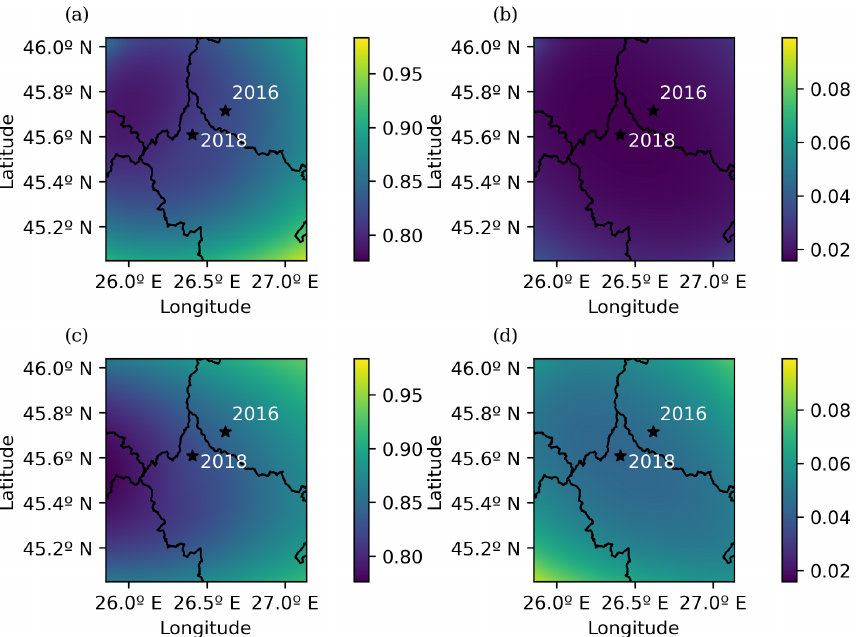
Figure 14. (a) The b -value spatial mapping for the Vrancea region from 2000 to 2016 using the parameters calculated in the previous Gaussian function fit, (b) b -value uncertainty for the Vrancea region from 2000 to 2016, (c) b -value spatial mapping for the catalog of the Vrancea region from 2016 to 2018 using the Gaussian kernel, (d) b -value uncertainty for the Vrancea region from 2016 to 2018. The black stars mark the epicenters of the earthquakes of 2016 and 2018.